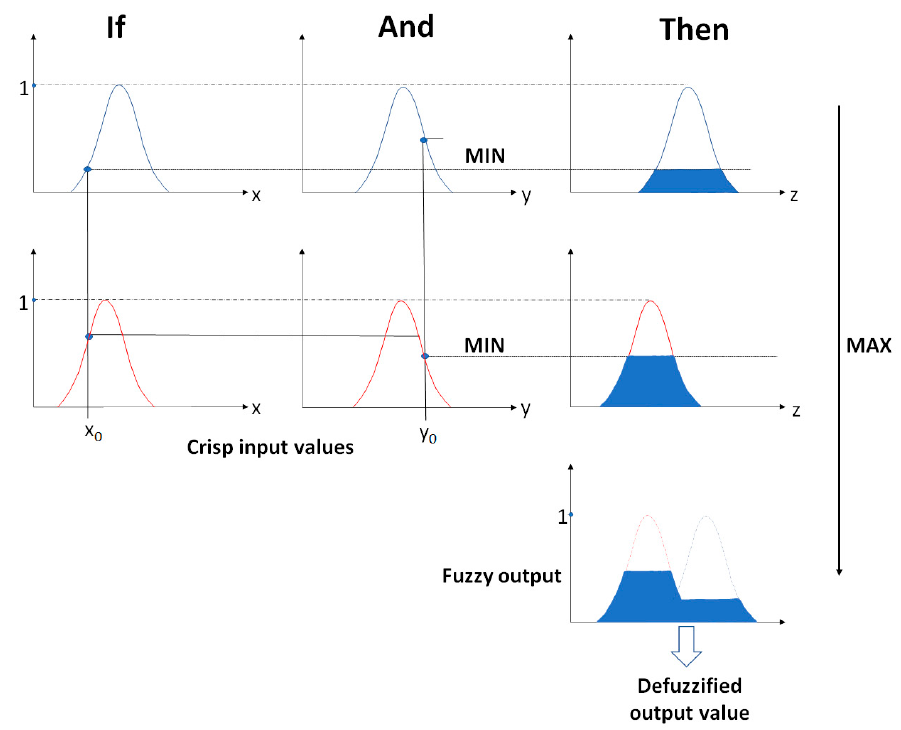
Figure 6. FIS of MAMDANI model: MIN and MAX operator.